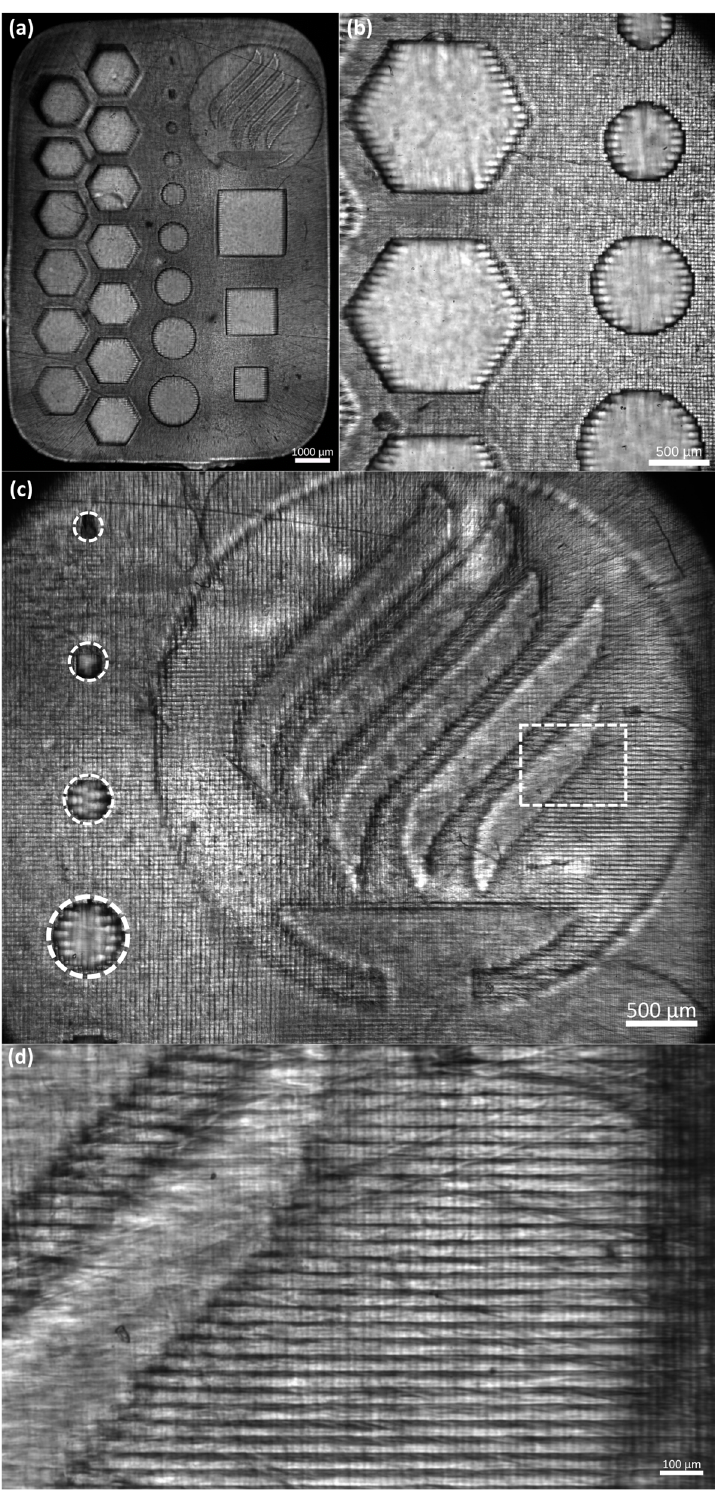
Figure 6. Microscope photo of manufacturing assessment for GelMA High 7.5%: ( a ) panoramic view; ( b ) hexagonal and circular features details; ( c ) Tecnologico de Monterrey with smallest circular features details (references in dotted white lines); and ( d ) horizontal lines details (referenced from dotted rectangle).